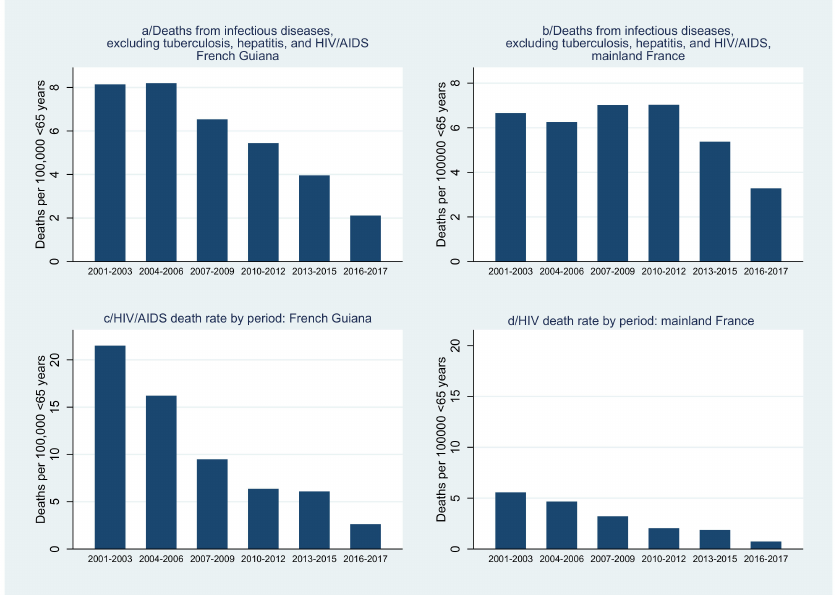
Figure 7. Evolution of the standardized death rate for infectious diseases other than tuberculosis, hepatitis, and HIV/AIDS (French Guiana ( a ) vs. mainland France ( b )), and for HIV/AIDS (French Guiana ( c ) vs. mainland France ( d )).